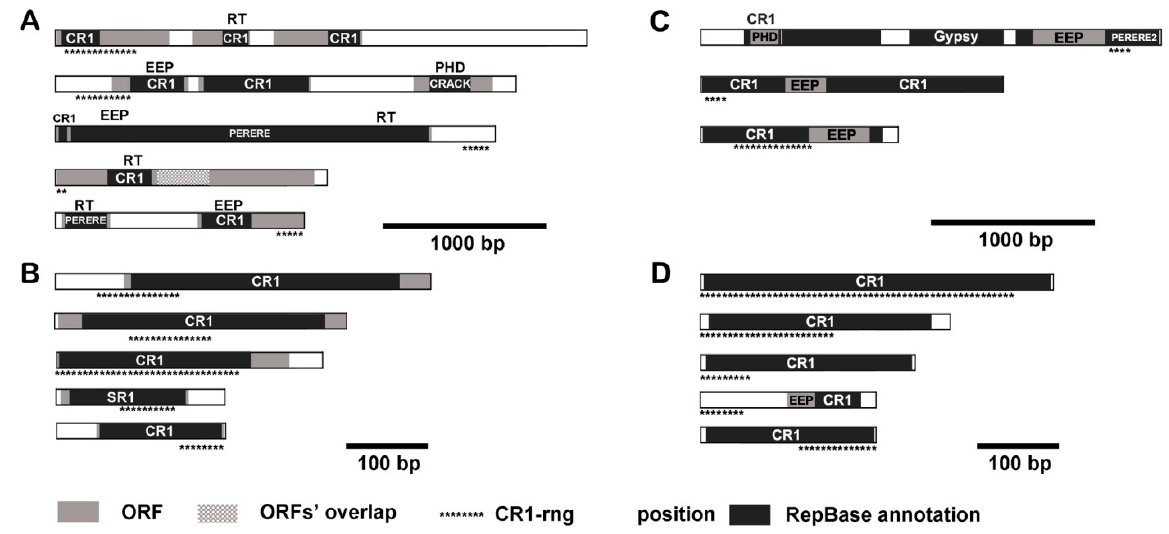
Figure 5. CR1-rng-containing transcripts ( A , B ) and mobilome contigs ( C , D ). Open reading frames (ORFs, grey boxes), Repbase-annotated fragments (black boxes), and transposon names are shown. Predicted conserved domains: RT—reverse transcriptase; EEP—exonuclease/endonuclease/phosphatase; PHD—plant homeodomain. Asterisks indicate the position of the match with CR1-rng. Transcripts that do not contain any conserved domains are not shown.